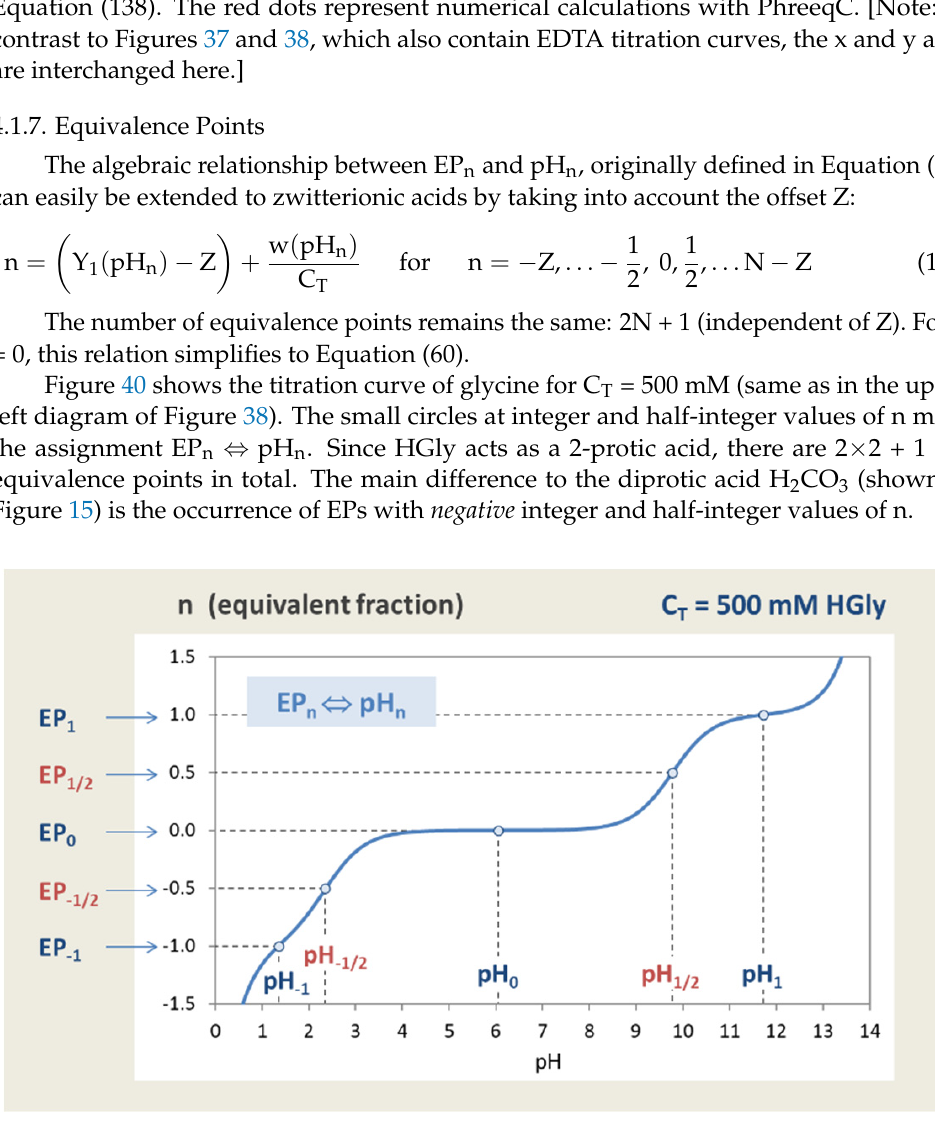
The right diagram in Figure 39 depicts titration curves for three C T values based on